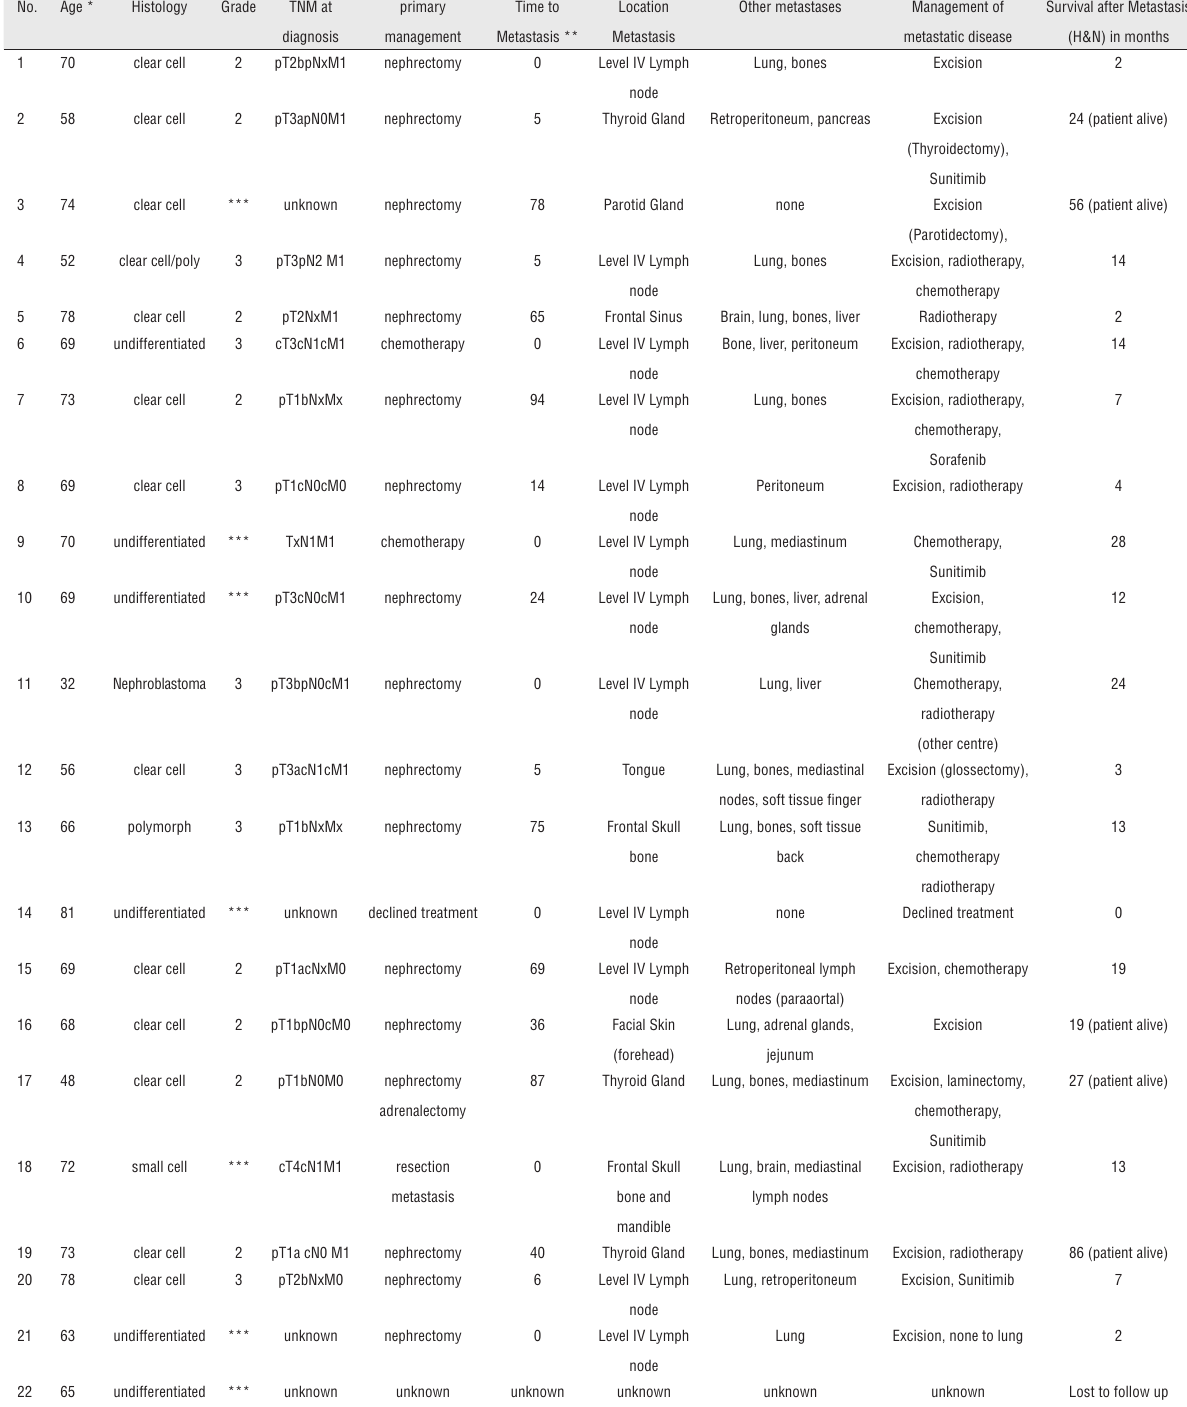
Table 1 - Patient and tumour